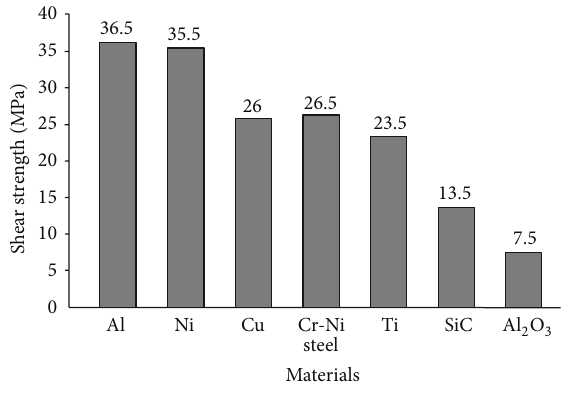
Figure 23: Measured results of shear strength of joints fabricated with Sn2La solder.